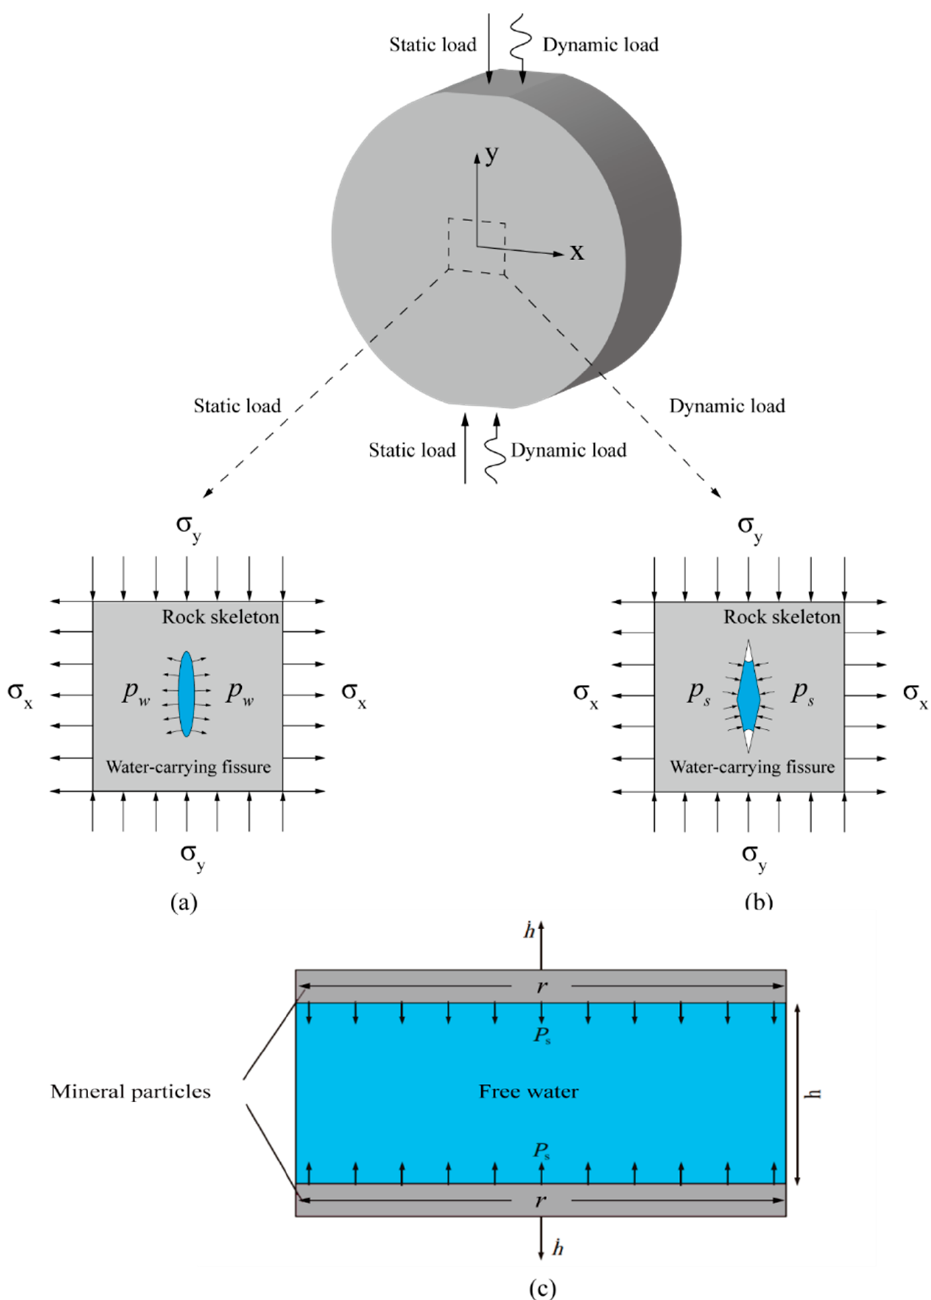
Figure 11. Pore water effect on rock under coupled static–dynamic loading: ( a ) pore water pressure under pre-static load promotes crack growth; ( b ) Stefan effect hinders crack growth under dynamic load; ( c ) a schematic diagram of the Stefan effect.